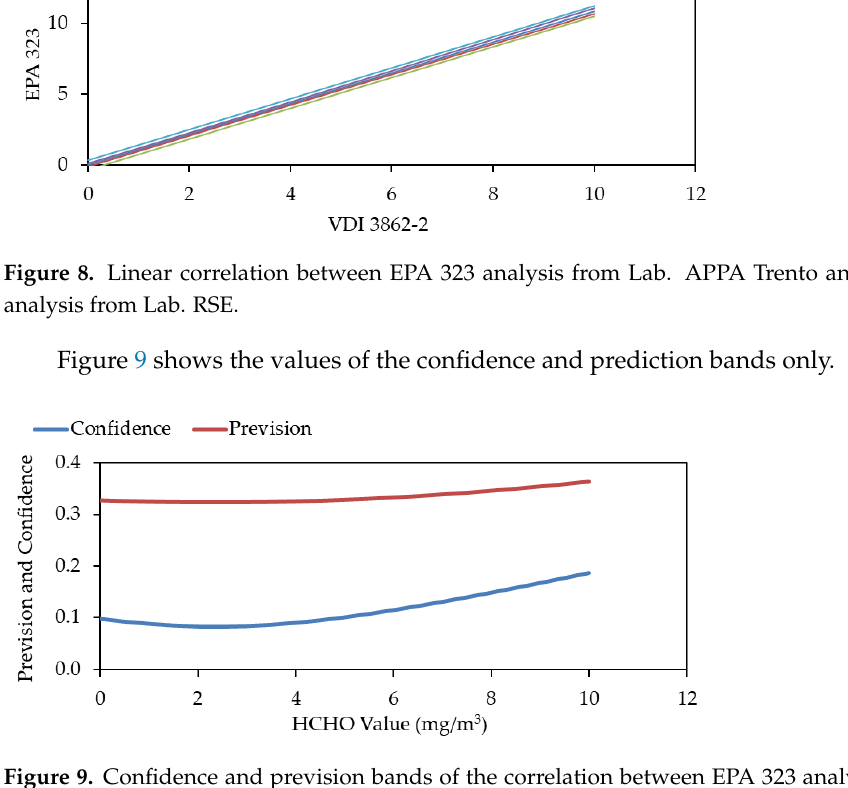
Figure 9. Confidence and prevision bands of the correlation between EPA 323 analysis from Lab. APPA Trento and VDI 3862-2 analysis from Lab. RSE.